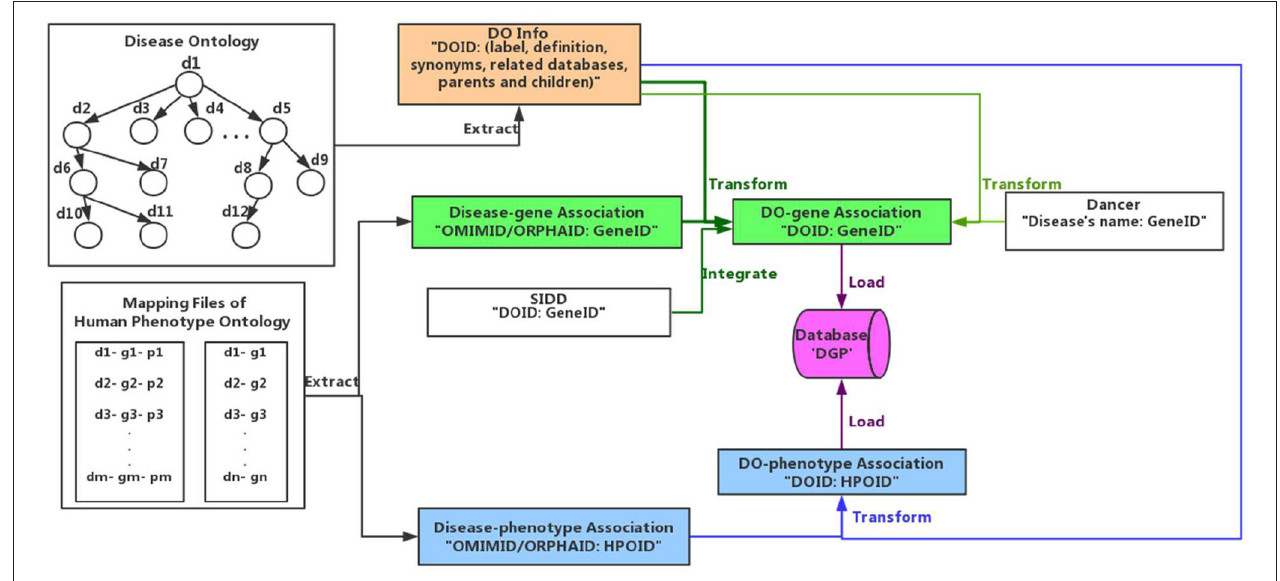
FIGURE 1 | Associated data